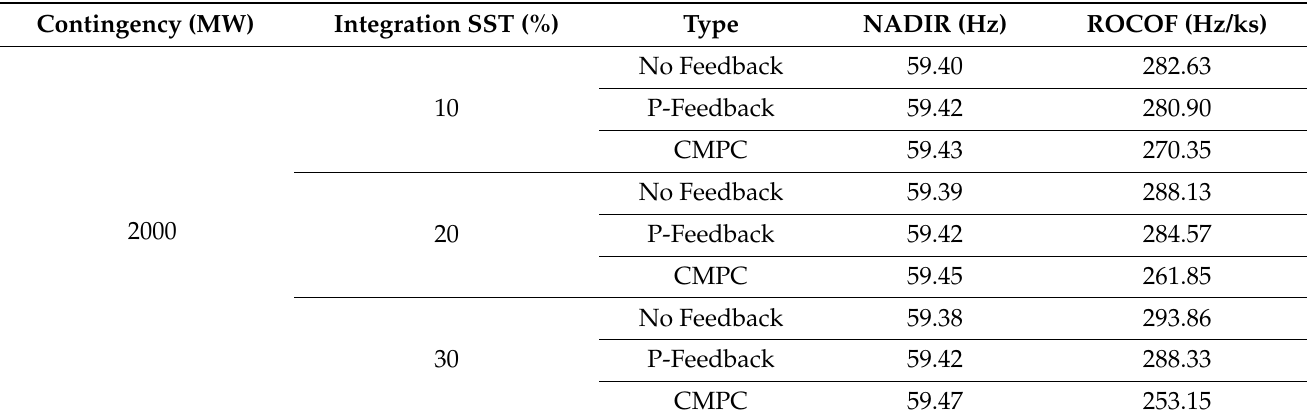
Table 4. NADIR and ROCOF